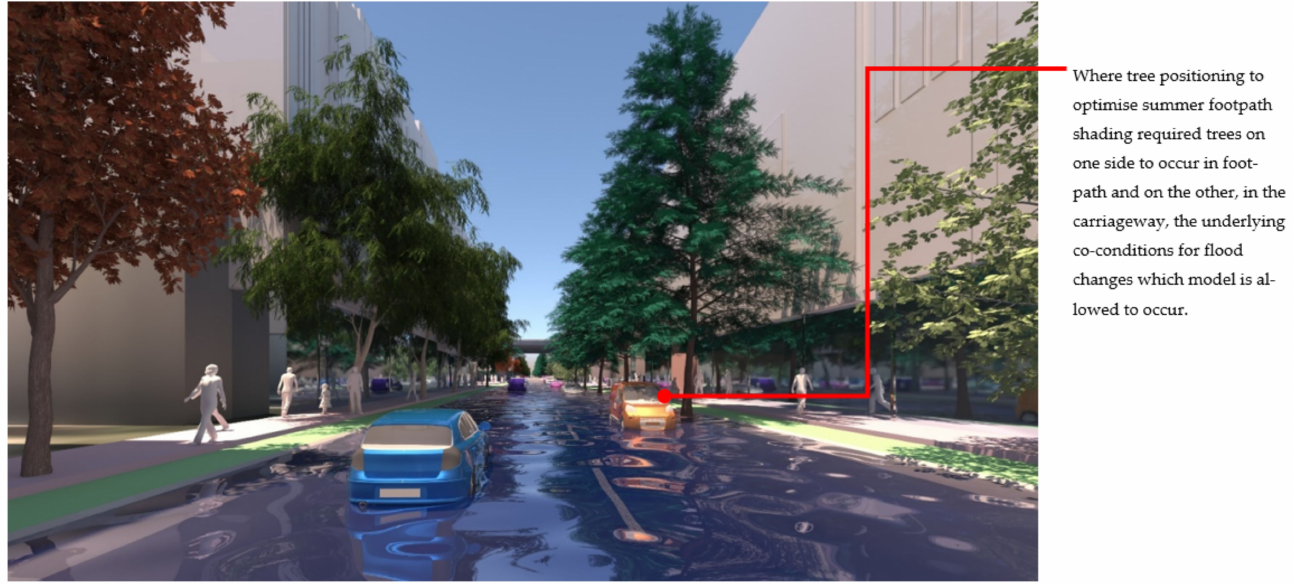
Figure 20. Macaulay Road view of Flood scenario (2) ‘road-based integrated water management’ during flood. Trees in this scene do not occur over symmetrical conditions. Trees planted in the road (right hand side) experience wet and overshadowed conditions and thus the species switches to Pinus strobus , while trees in the footpath still experience dry overshadowed conditions and thus remain as Angophora costata . Image by authors using multi-criteria street tree design decision support modelling approach in Autodesk™ 3ds